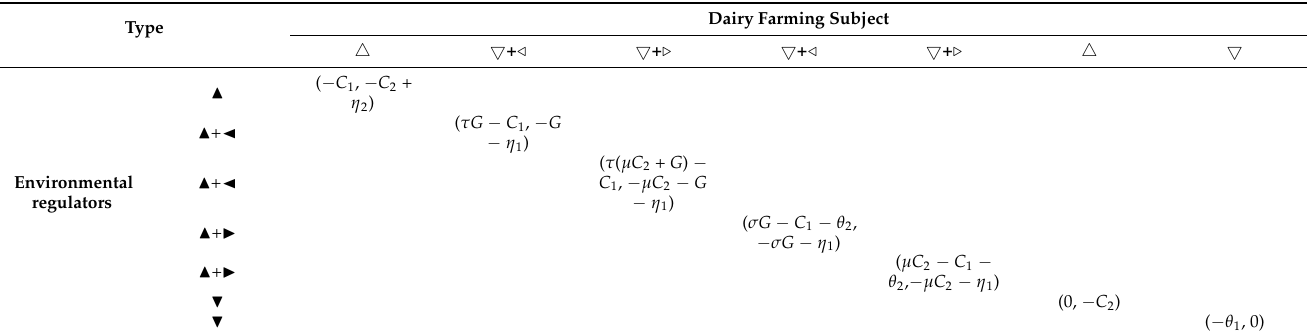
Table 3. Dynamic game scenarios between environmental regulators and dairy farmers and results of benefits for